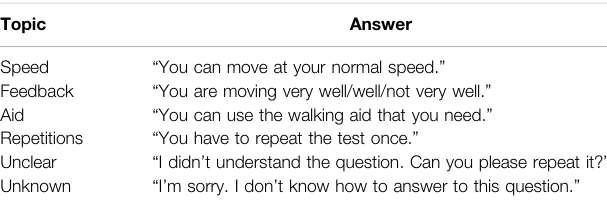
TABLE 1 | The list of topics and related answer provided through verbal interaction. Topic Answer